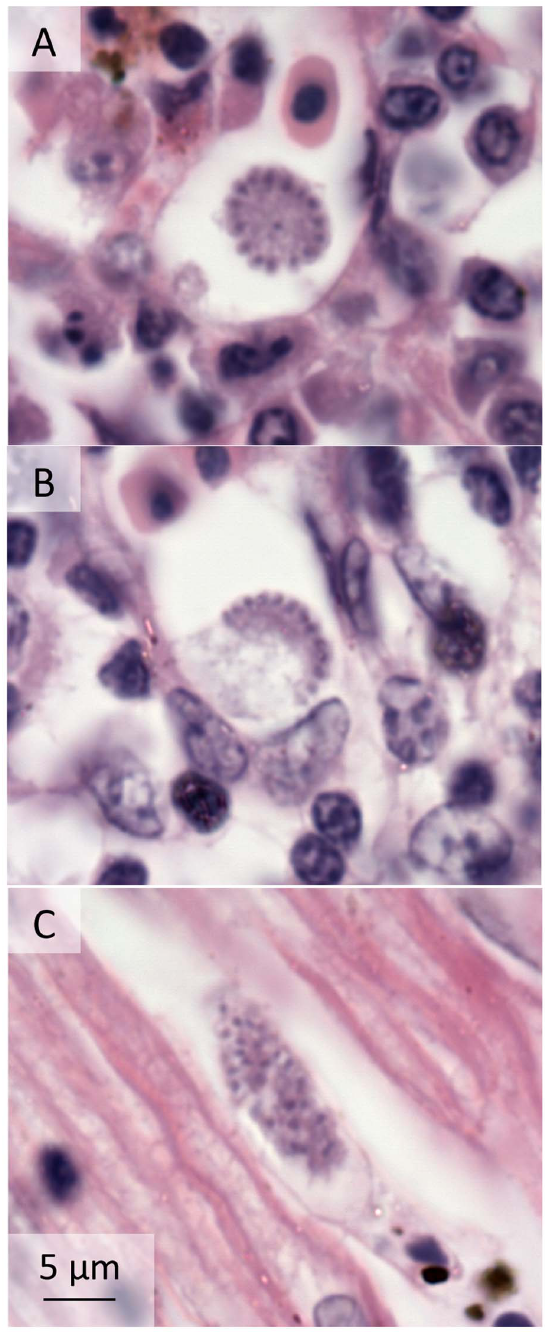
Figure 3. Tissue meronts of Plasmodium ( Haemamoeba ) tejerai in tissues of Magellanic penguins ( Spheniscusmagellanicus ). Hema- toxilin-Eosin, penguin 584: liver (a), parathyroid (b) and heart (c).